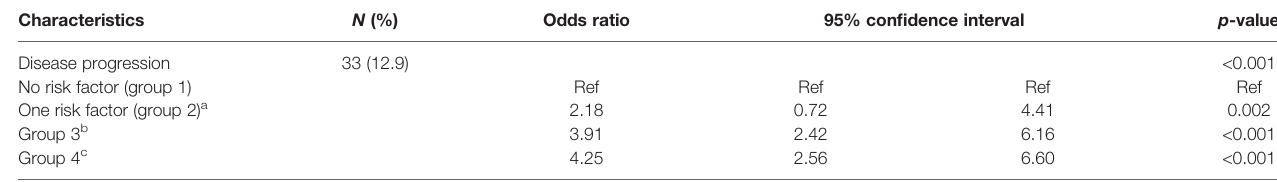
TABLE 4 | Predictive model for primary resistance to palbociclib with letrozole as fi rst-line treatment for HR+, HER2-advanced breast cancer according to risk factor characteristics ( N = 256). Characteristics